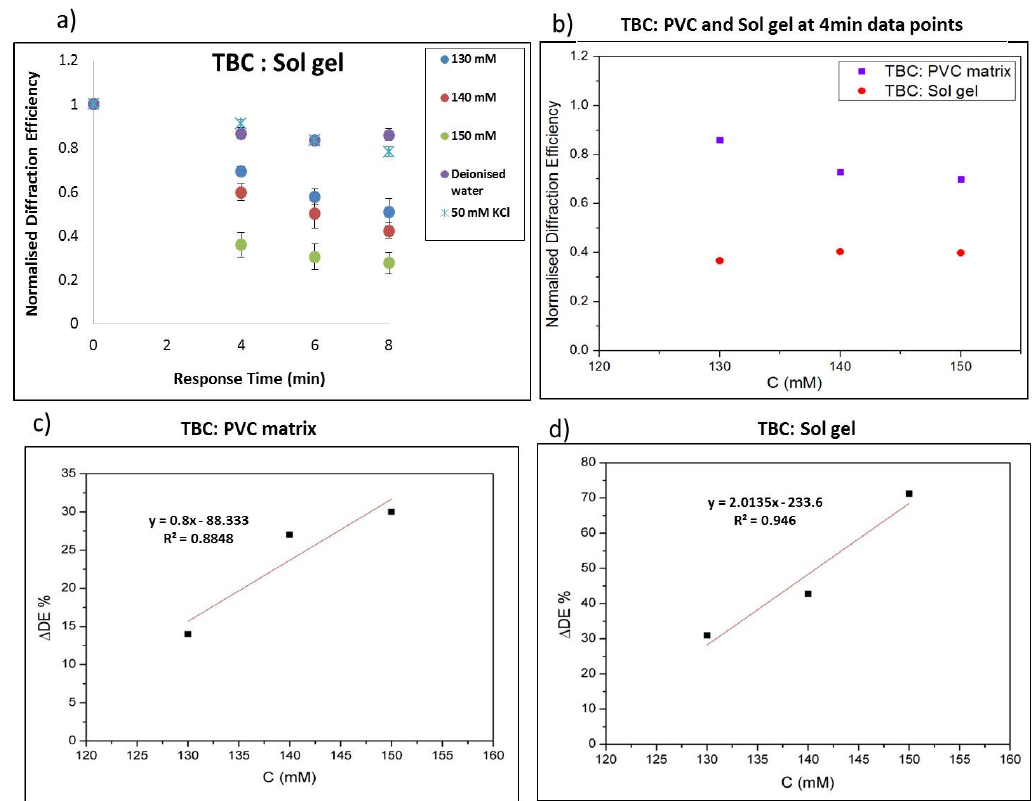
Figure 12. ( a ) Normalised diffraction efficiency change response TBC photonic structures in sol-gel layers exposure to (130–150 mM) Na + , ( b ) comparison PVC and Sol gel at 4 min data points, ( c ) Sensitivity of the response at 4 min for TBC in PVC and ( d ) sol gel.